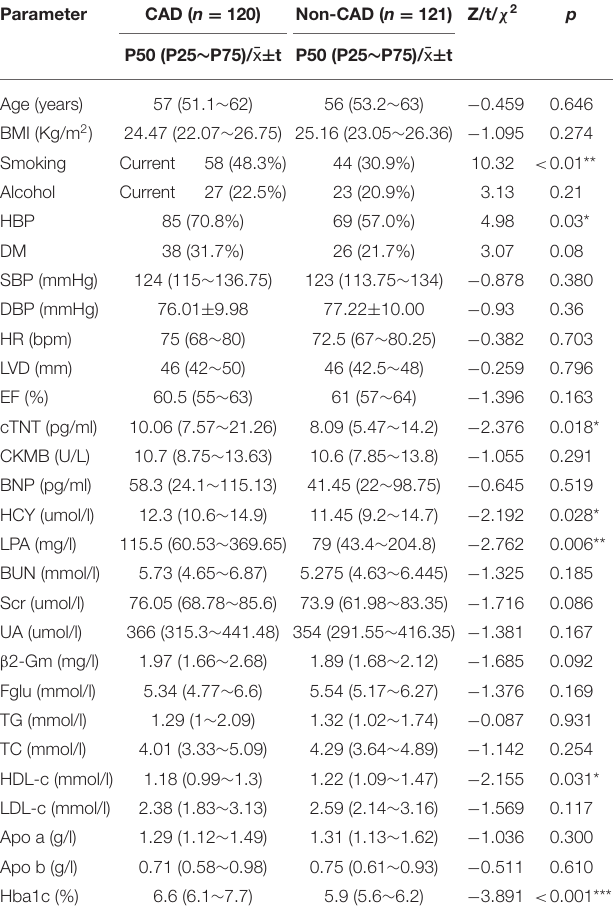
TABLE 1 | Information of CHD patients and non-CHD patients.